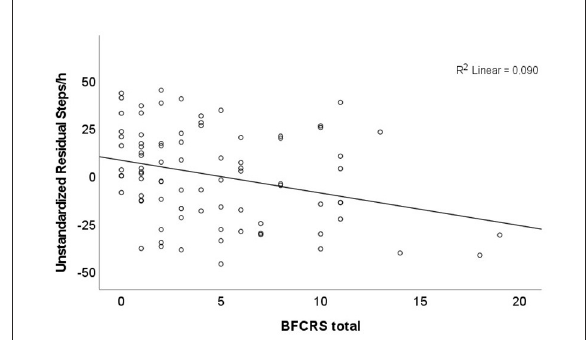
FIGURE1 Association between Steps/h (steps per hour) and Bush Francis catatonia Rating Scale (BFCRS) total scores controlling for age, medication (olanzapine equivalents), and body mass index